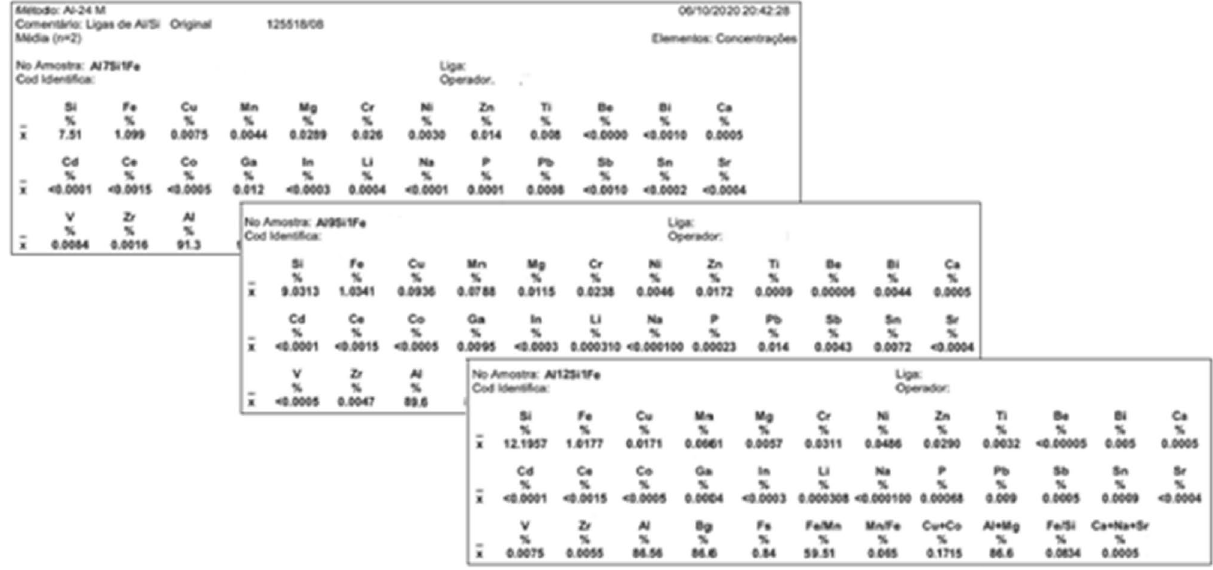
Table 2. Atomic absorption spectrometry report (analysed by LATASA).